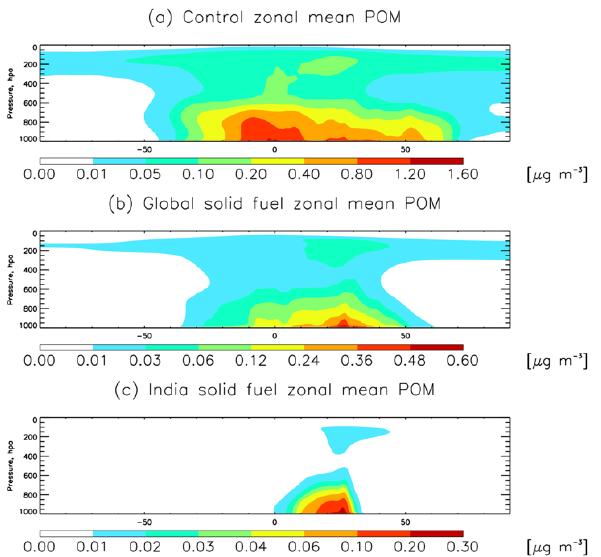
Figure 5. Same as Fig. 4 but for POM.